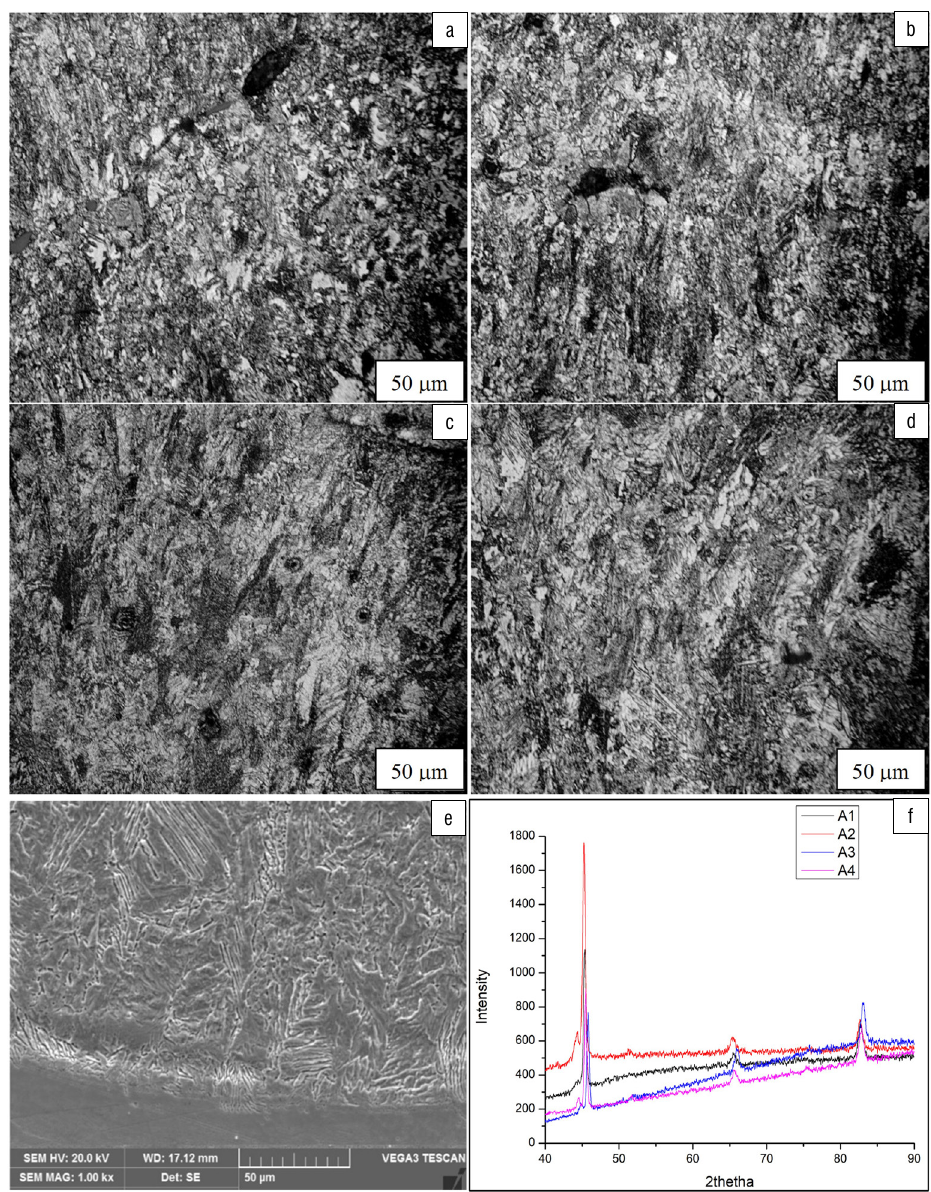
Figure 3: (a–d) Optical images of samples A1, A2, A3, and A4, respectively; (e) scanning electron micrograph of A2; and (f) X-ray diffraction spectra of specimens produced at different laser